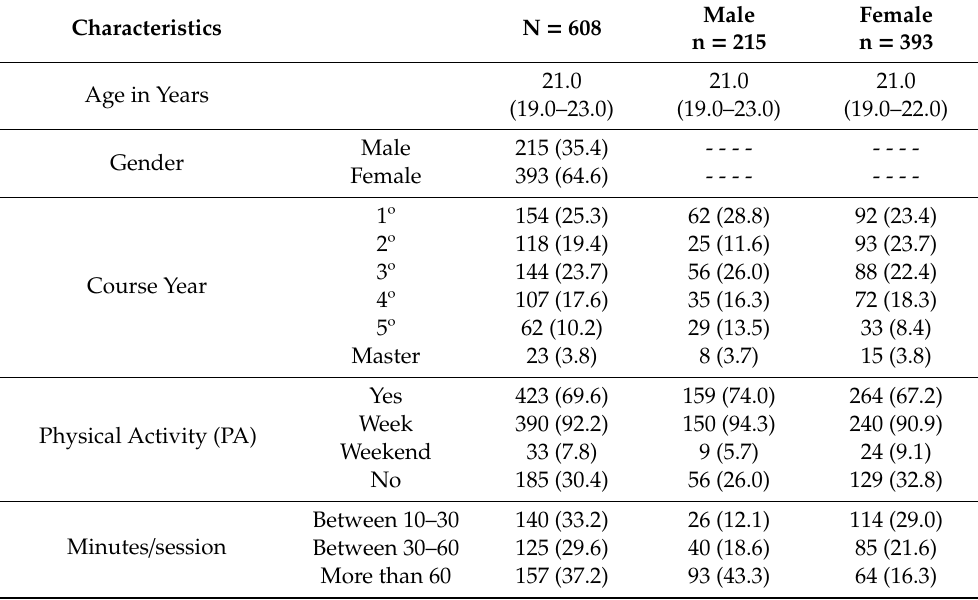
Table 1. Characteristics of the sample. Continuous variables expressed as a median (interquartile range); categorical variables expressed as absolute frequency (relative